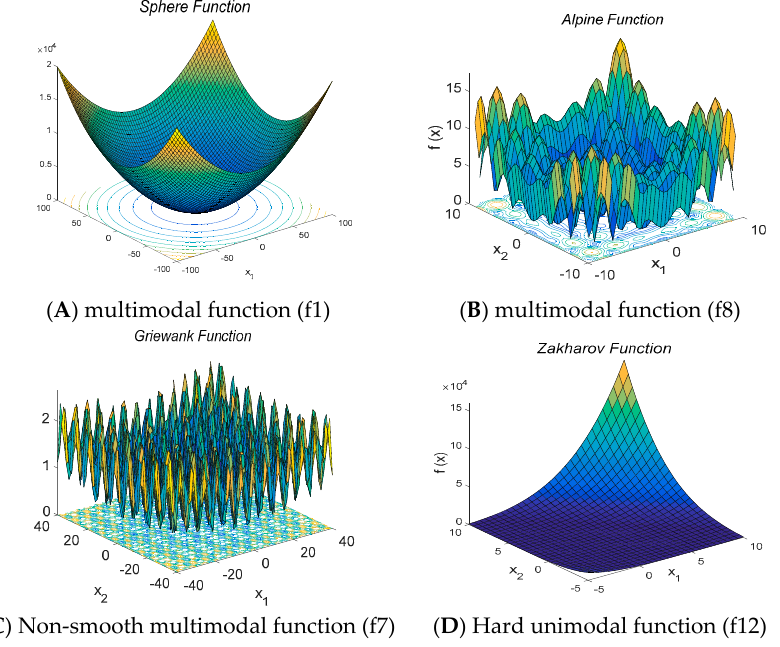
Figure 1. Sample of tested benchmark functions. Table 2. Selected benchmark